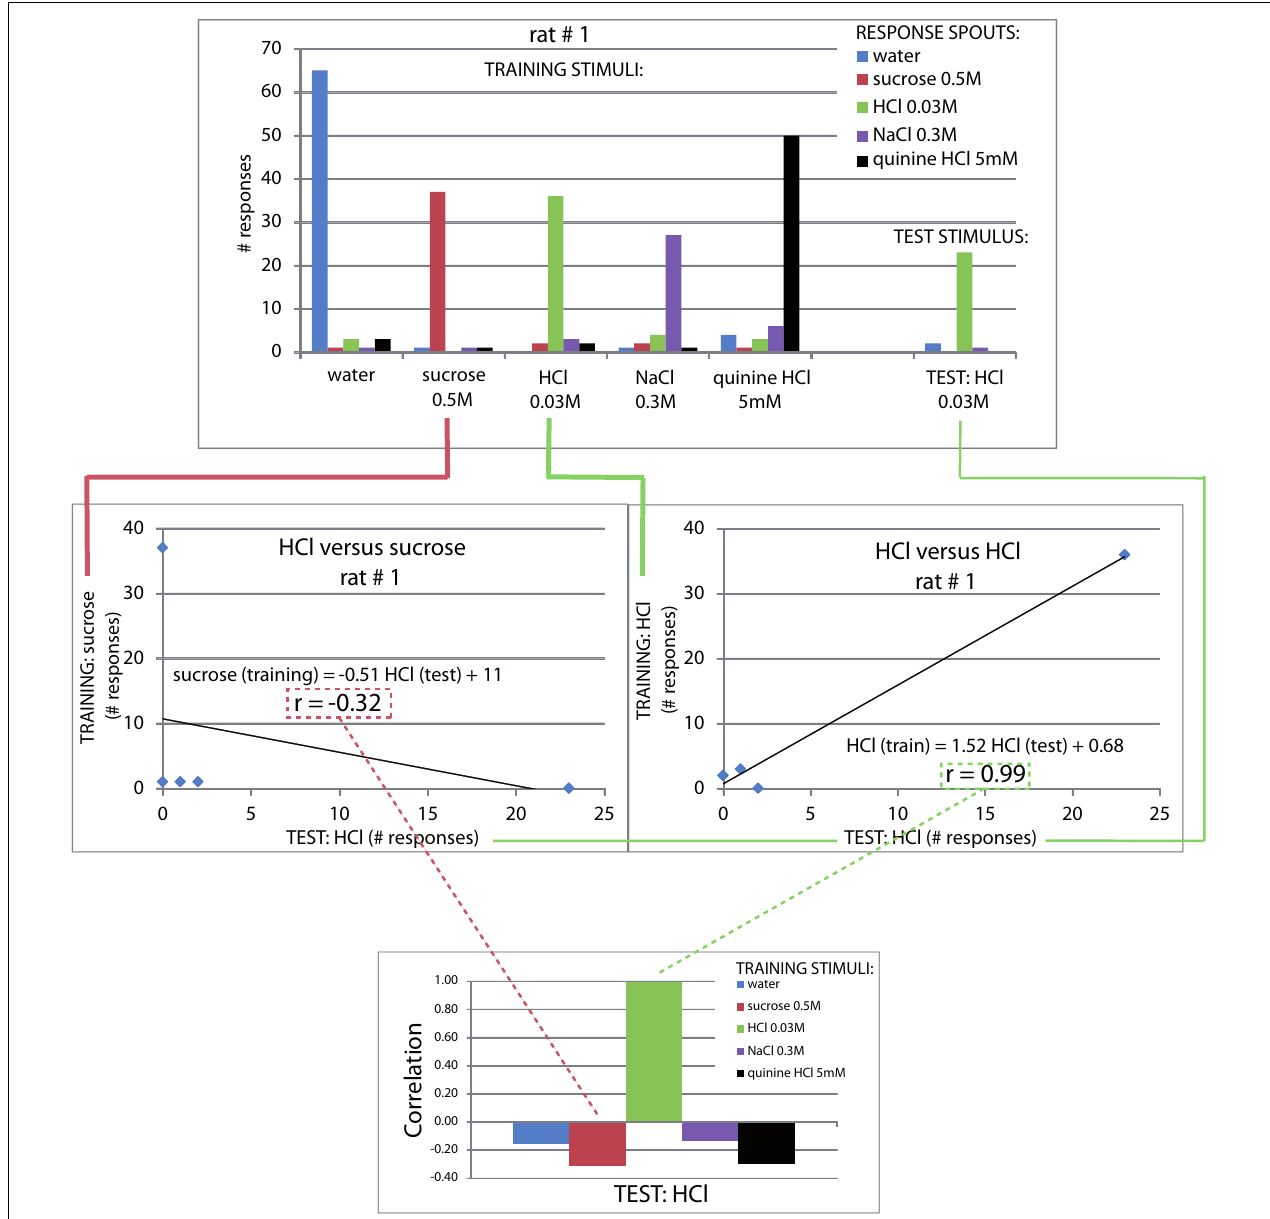
stimulus HCl ( r =− 0.32). Middle right: the correlation between test stimulus HCl and train stimulus HCl is expectedly much higher ( r = 0.99). Bottom: the correlation between the test stimulus and all five training stimuli is calculated for each rat, and reported as the mean across all four rats (e.g., Figure